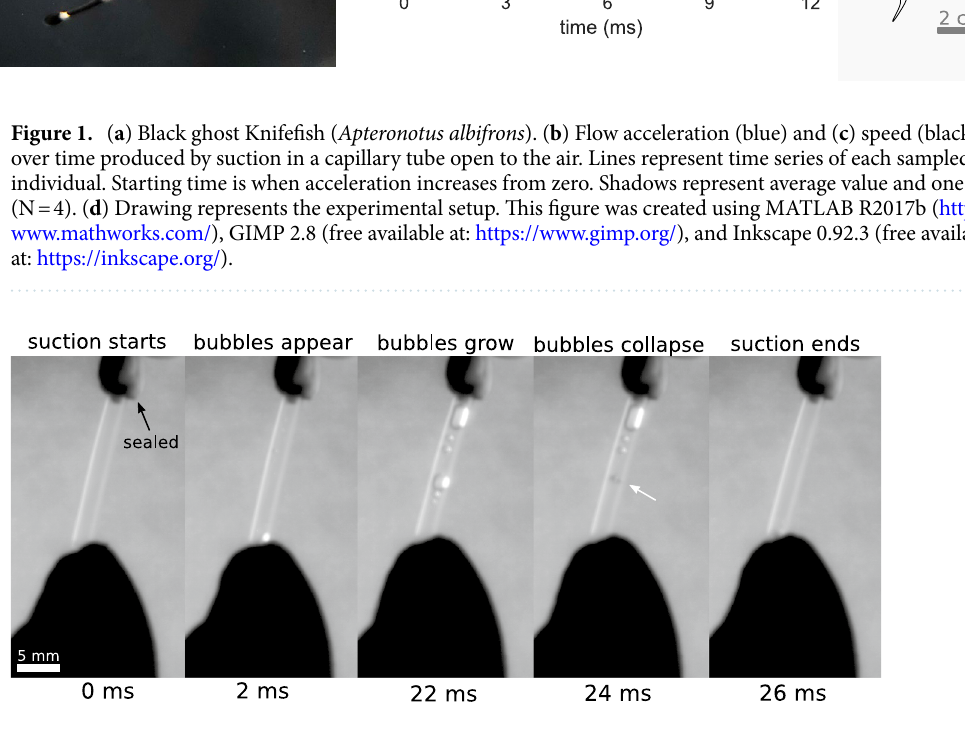
Figure 2. Frame sequence filmed at 500 frames/s of a fish suction feeding a the tip of a sealed tube, showing large cavitation bubbles. This figure was created using GIMP 2.8 (free available at: https ://www.gimp.org/) and Inkscape 0.92 (free available at: https ://inksc